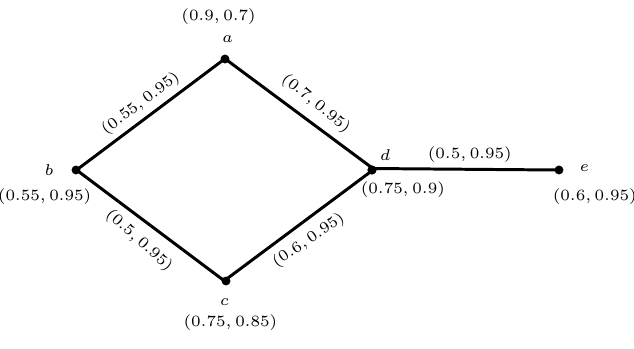
= ( ) . , = ( C , D ) 3 3 3 P 3 C 3 D 3